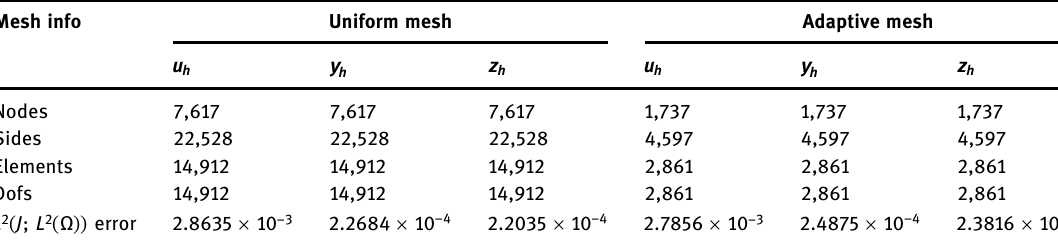
Table 1: Numerical results based on uniform and adaptive